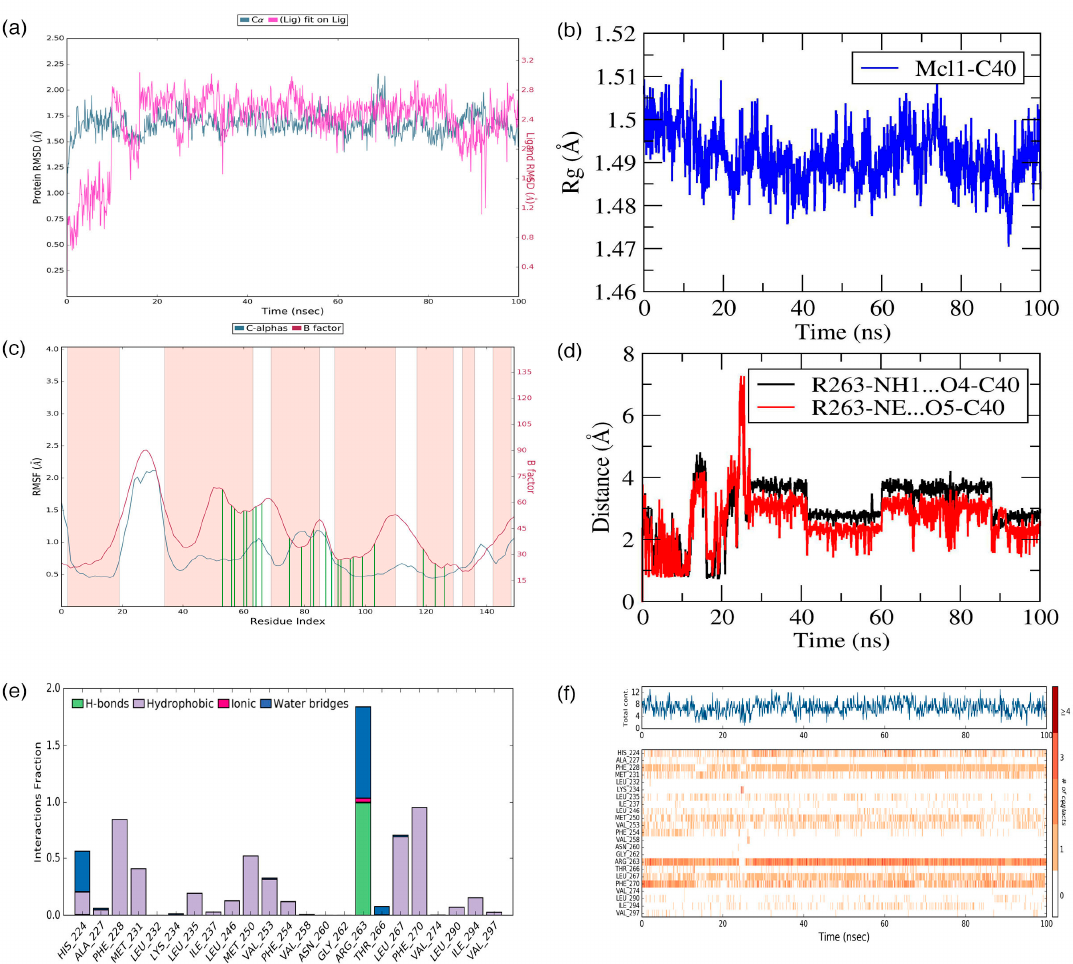
Figure 8. ( a ) Root mean squared deviation ( RMSD ), ( b ) radius of gyration ( Rg ), ( c ) root mean squared fluctuation ( RMSF ), ( d ) distances between the polar atoms, ( e ) interacting frequency, and ( f ) interaction types monitored for the Mcl1– C40 complex during MD simulation.